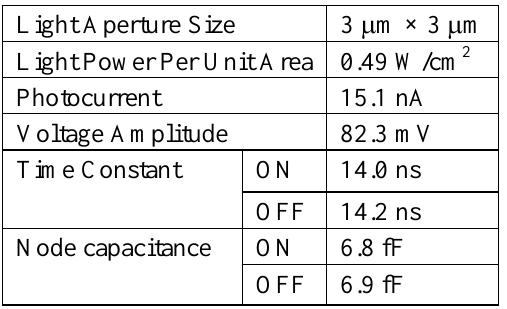
Table 1. Summary of the simulation results.